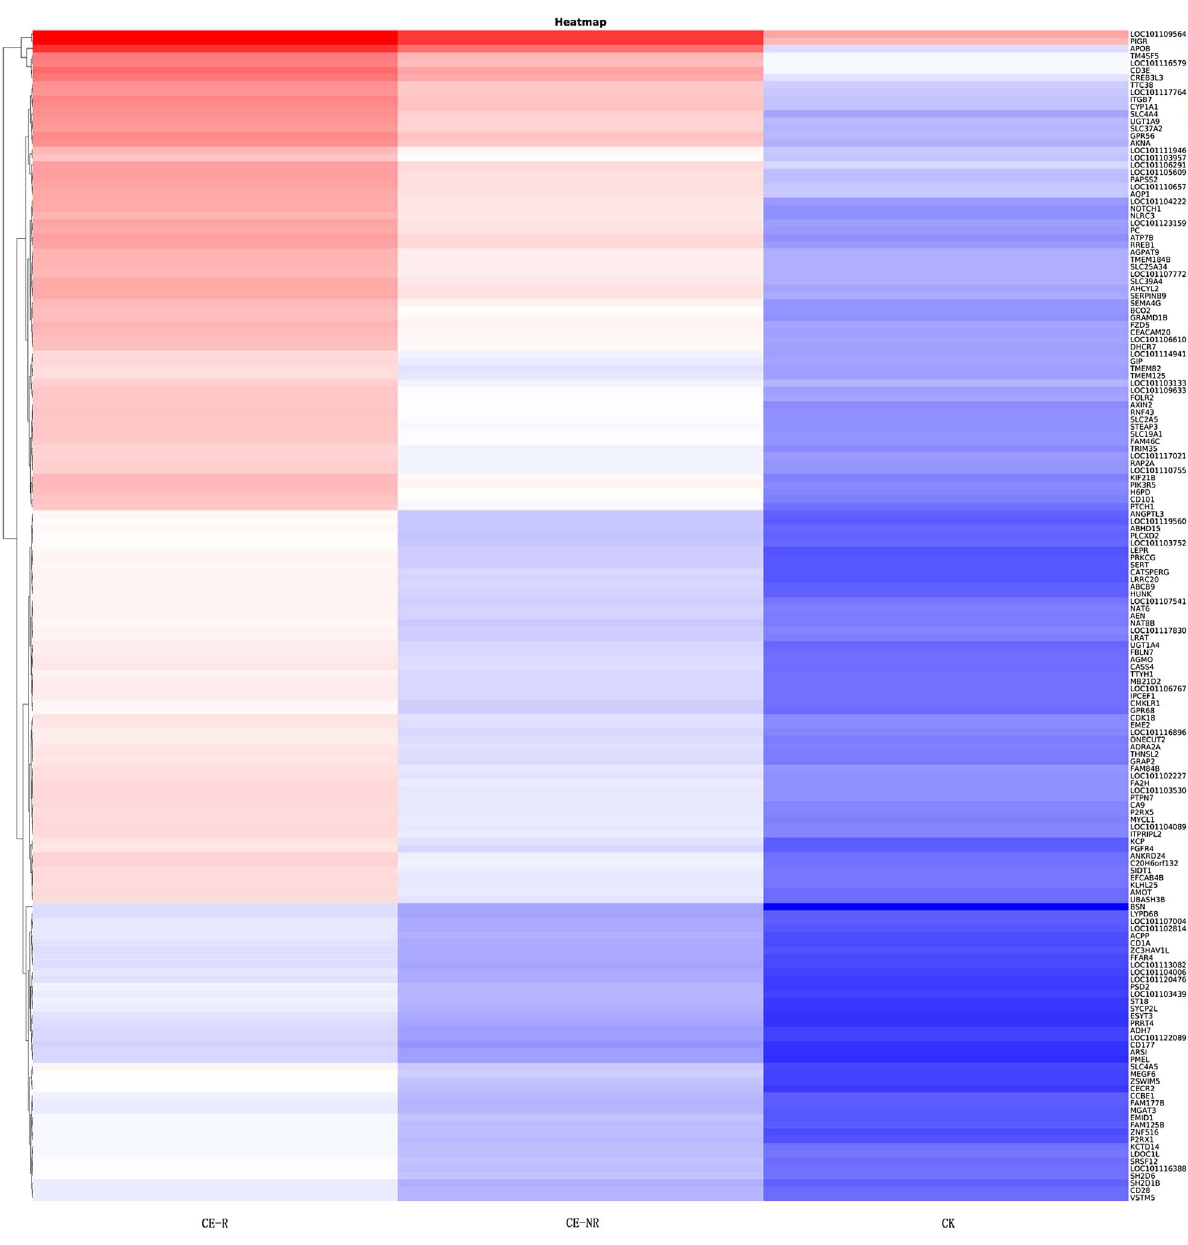
Figure 3. Heatmap of partial DEGs between sample